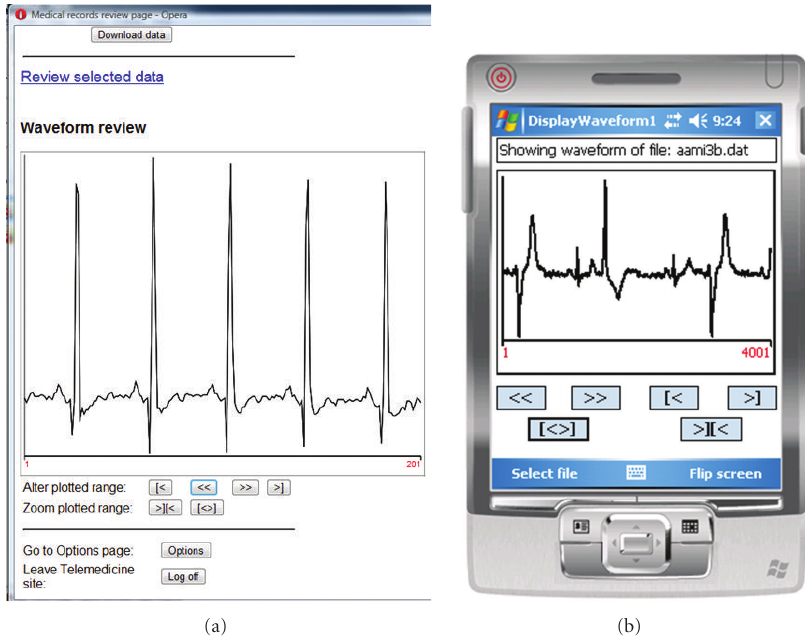
Figure 4: Example of waveform display on browser (left) and PDA application